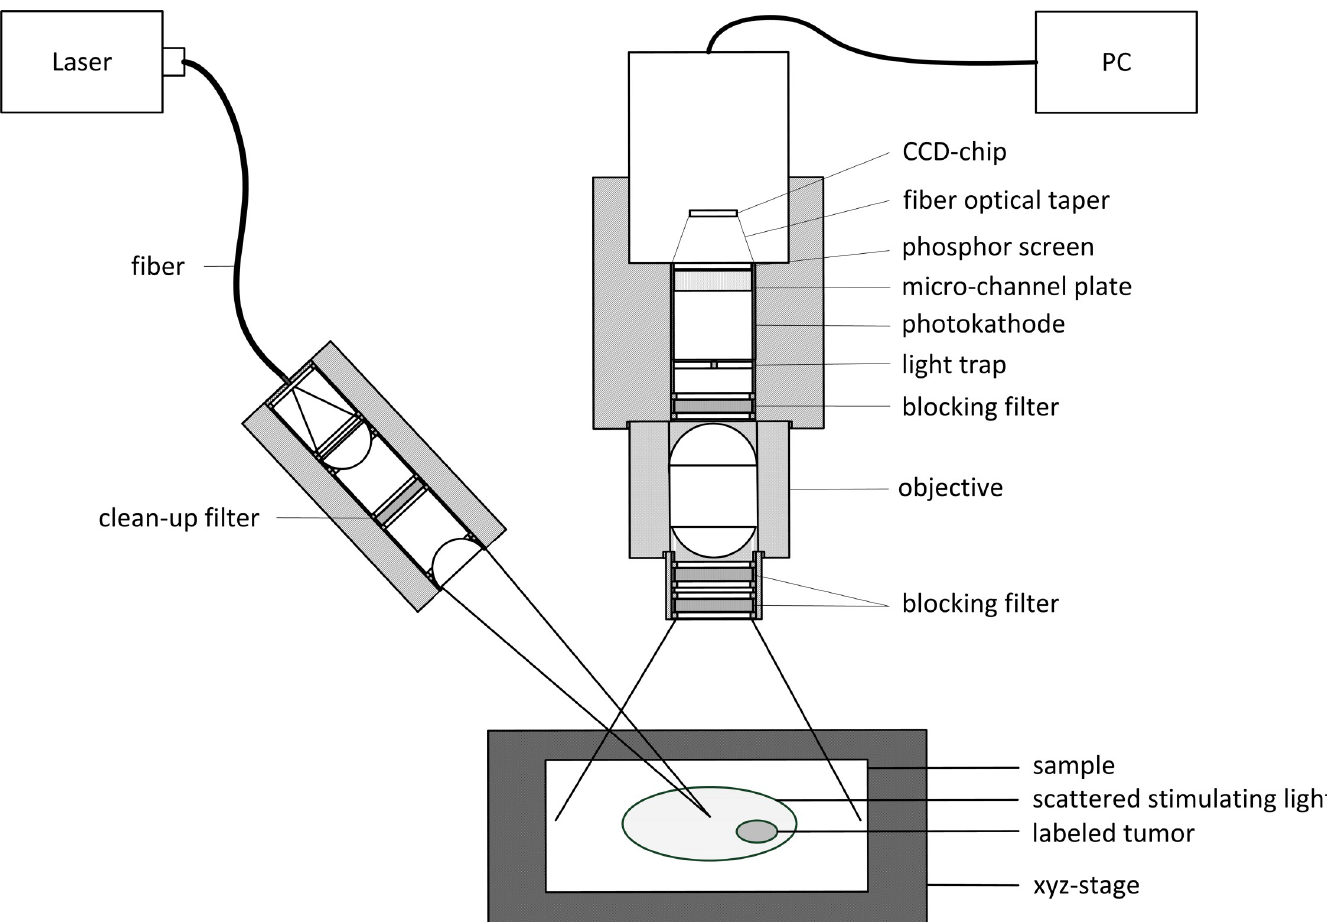
Fig 1. Schematic diagram of the developed fluorescence imaging